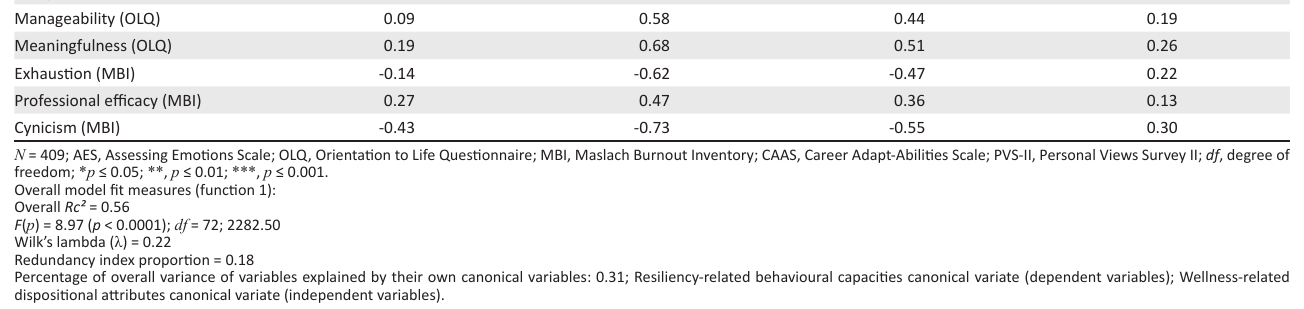
TABLE 4b: Standardised canonical correlation analysis results for the first canonical function variate. Variate/variables Canonical coefficient (weight) Structure coefficient (canonical Canonical cross-loadings ( Rc ) Squared multiple correlation loading) ( Rc) ( Rc² ) Concern (CAAS) 0.22 0.46 0.35 0.11 Control (CAAS) 0.09 0.46 0.35 0.11 Curiosity (CAAS) -0.16 0.05 Cooperation (CAAS) -0.05 Confidence (CAAS) 0.23 0.51 0.14 Commitment-Alienation (PVS-II) 0.42 0.87 0.65 0.43 Control-Powerlessness (PVS-II) 0.54 0.91 0.48 Challenge-Threat (PVS-II) -0.14 0.09 N = 409; AES, Assessing Emotions Scale; OLQ, Orientation to Life Questionnaire; MBI, Maslach Burnout Inventory; CAAS, Career Adapt-Abilities Scale; PVS-II, Personal Views Survey II; df , degree of freedom; * p ≤ 0.05; ** , p ≤ 0.01; *** , p ≤ 0.001. Overall model fit measures (function 1): Overall Rc² = 0.56